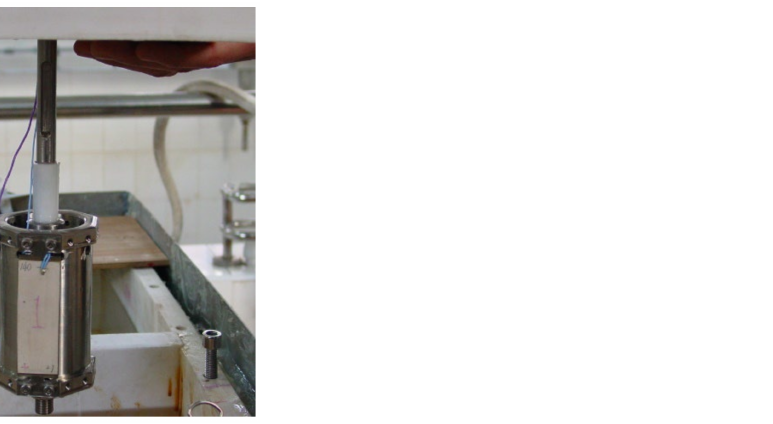
Figure 6. Physical diagram of the experimental heating device of transmitting piezoelectric vibrators.